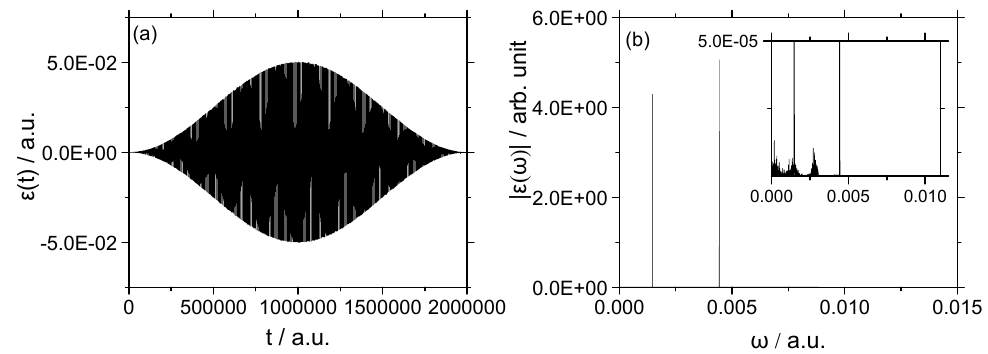
Figure 10. ( a ) The optimal field ε ( t ) obtained with the initial guess, Equation (22), for the vibrational–rotational excitation, ( v = 0, J = 0) → ( v = 1, J = 2), in the strong-field regime; ( b ) the spectrum of ε ( t ).